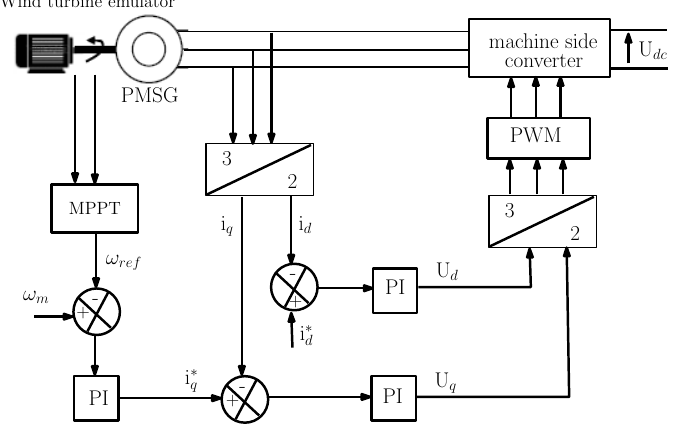
Figure 5. Control scheme of the WECS.